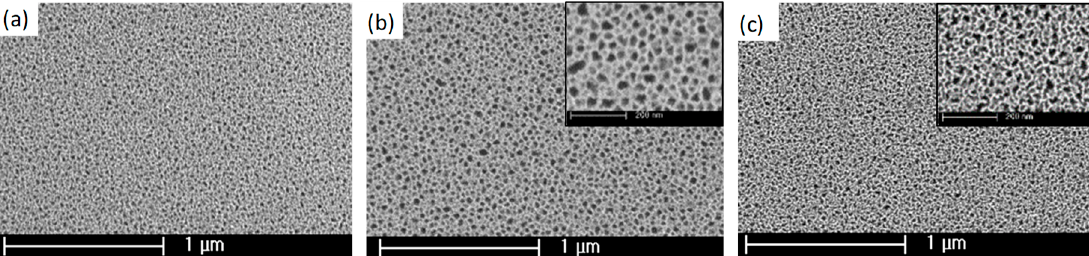
Figure 1. Molecular structure of ( a ) 3-aminopropyl-triethoxy-silane (APTS) and ( b ) 1 H ,1 H ,2 H ,2 H - perfluorodecyl-triethoxy-silane